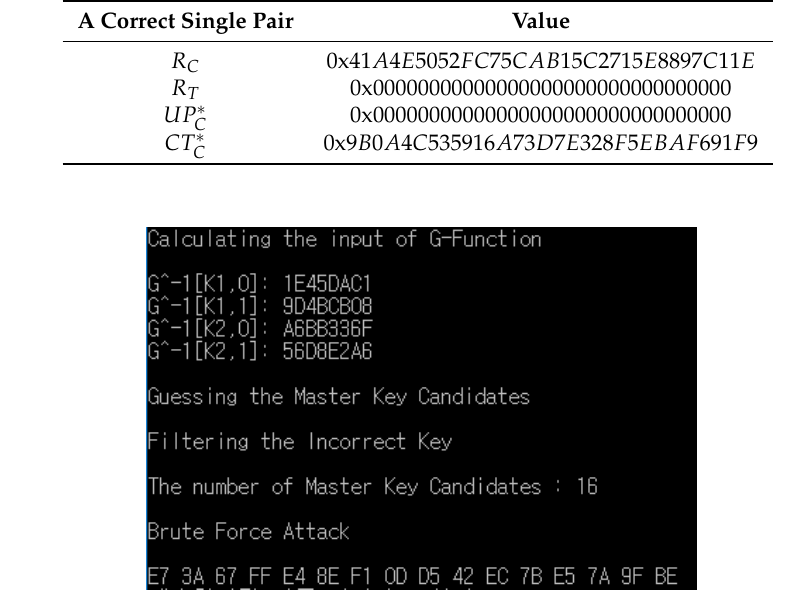
Figure 9. Analyzed master